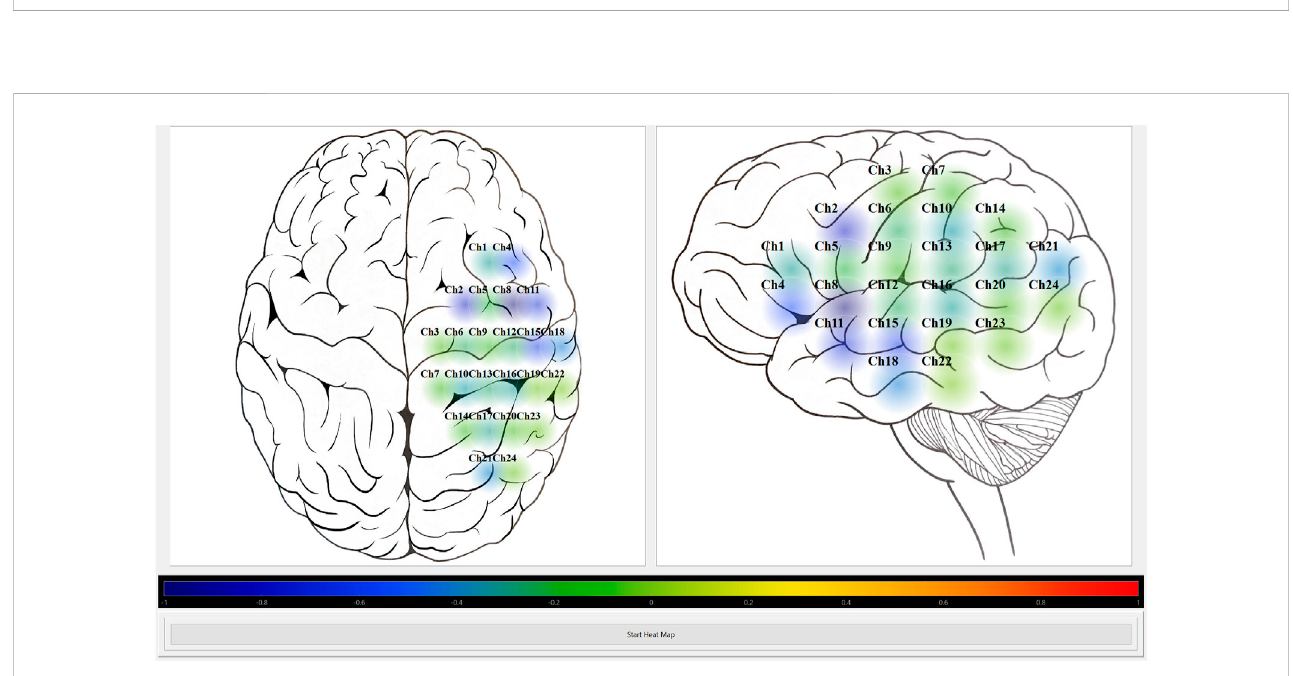
FIGURE 6 HeatmapmodulevisuallydisplayingHbOautoregulationindexfor24channelgrid.ShowsthescreenshotofthePythonheatmapmodule ’ sGUIrunning in “ of fl ine ” mode for HbO autoregulation index of a 24 channel grid recording. The colour bar represents the CVR index scale from Blue = -1 (intact CVR) to Red = +1 (impaired CVR). CVR, cerebrovascular reactivity; GUI, graphical user interface; HbO,